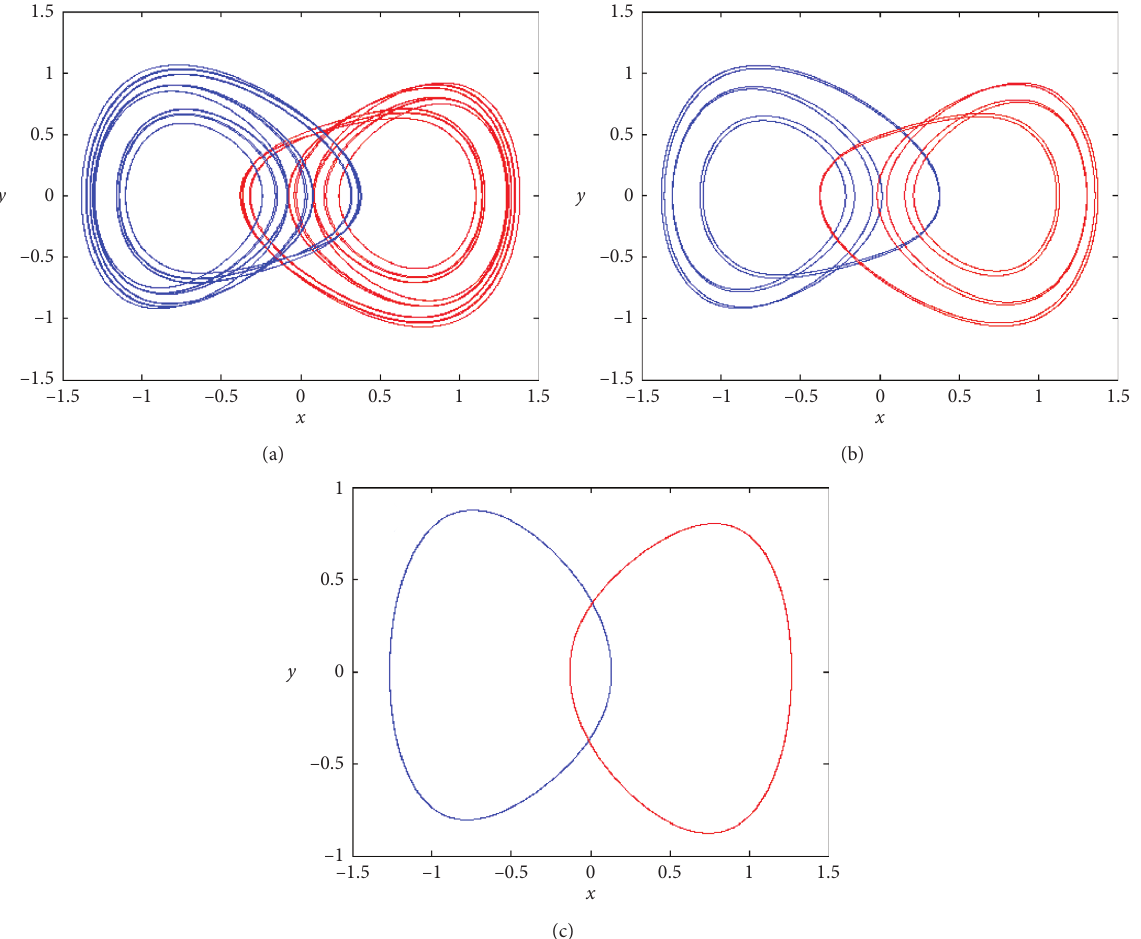
Figure 11: Coexistence of six periodic attractors at point k � 2.6714 of Figure 9(b), for different values of the initial conditions ( x (0), y (0), z (0)): (a) a finite n-period attractor and its symmetry for ( ± 0.028, 0, 0); (b) a period-6 attractor and its symmetry for ( ± 0.06, 0, 0); (c) a period-1 attractor and its symmetry for ( ± 0.108, 0,